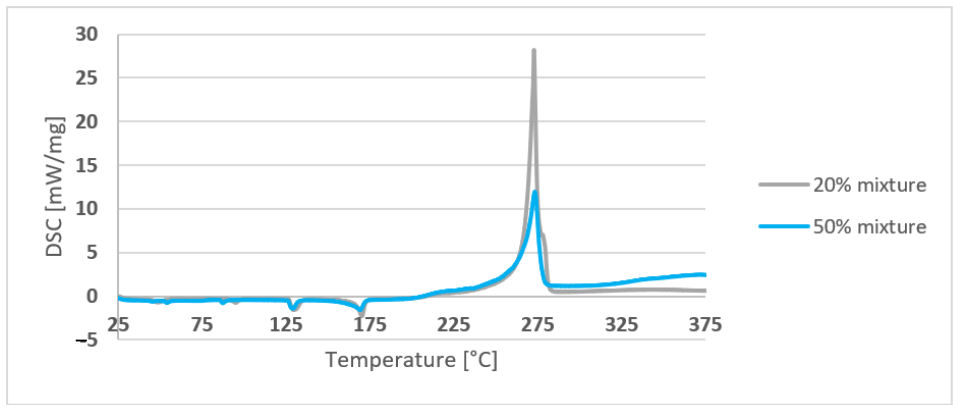
Figure 4. DSC analysis showing the influence of AN and PP mixture composition on the mixture’s thermal properties, heat rate 10 °C/min.